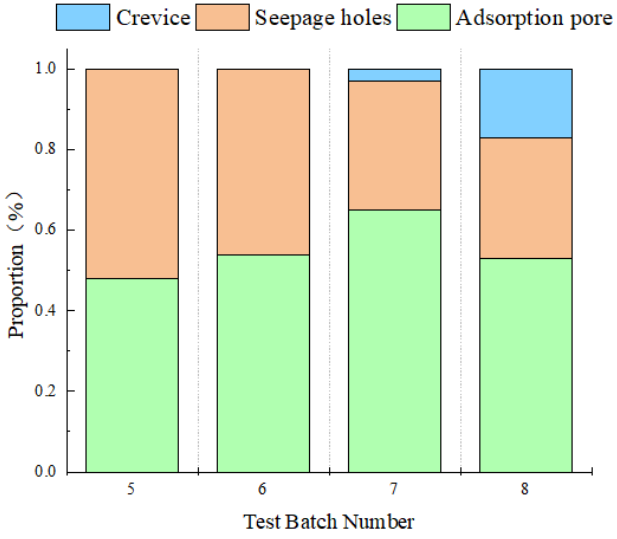
Figure 12. Proportion of the aperture distribution after dissolution under different test conditions.